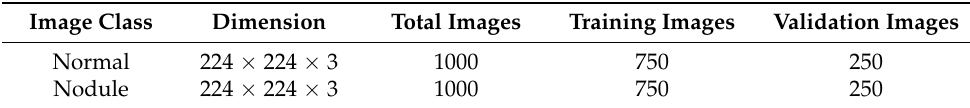
Figure 2. Sample test images considered in this study. Table 2. The lung CT images analyzed in the